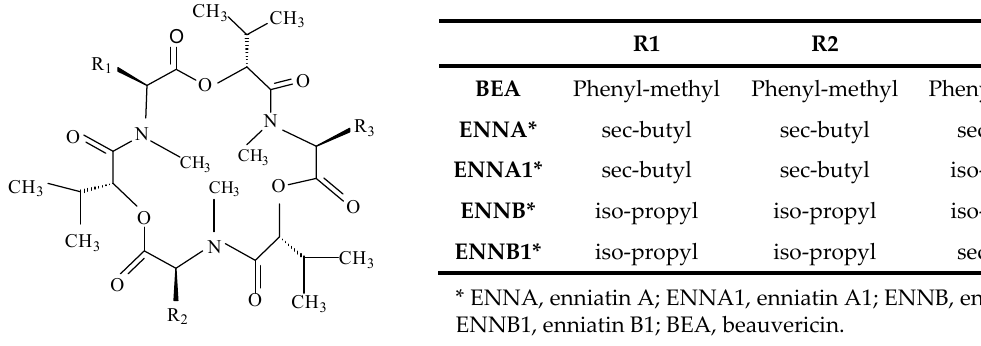
Figure 1. The structure of Enniatins (ENNs) and Beauvericin (BEA).